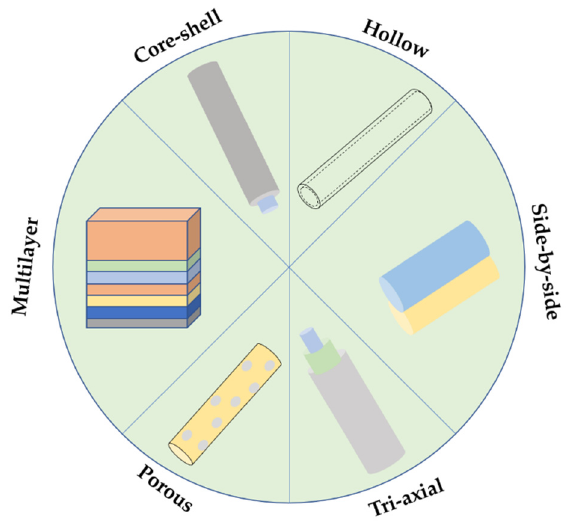
Figure 2. Schematic representation of the most common electrospun fiber structural organizations.